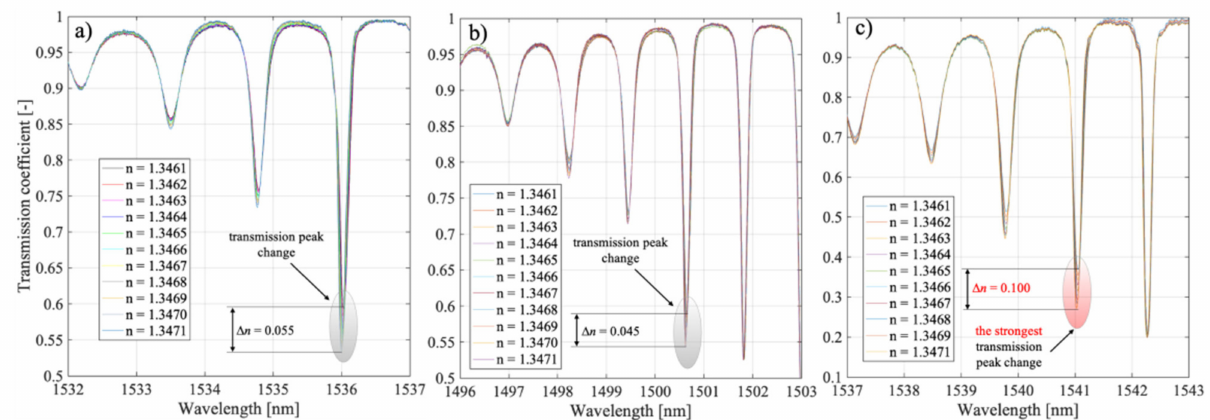
Figure 18. Spectral characteristics of the P-TFBG system in the selected spectral range for variable tilting angles of TFBG structures amounting to: ( a ) 5 ◦ , ( b ) 6 ◦ , ( c ) 7 ◦ .